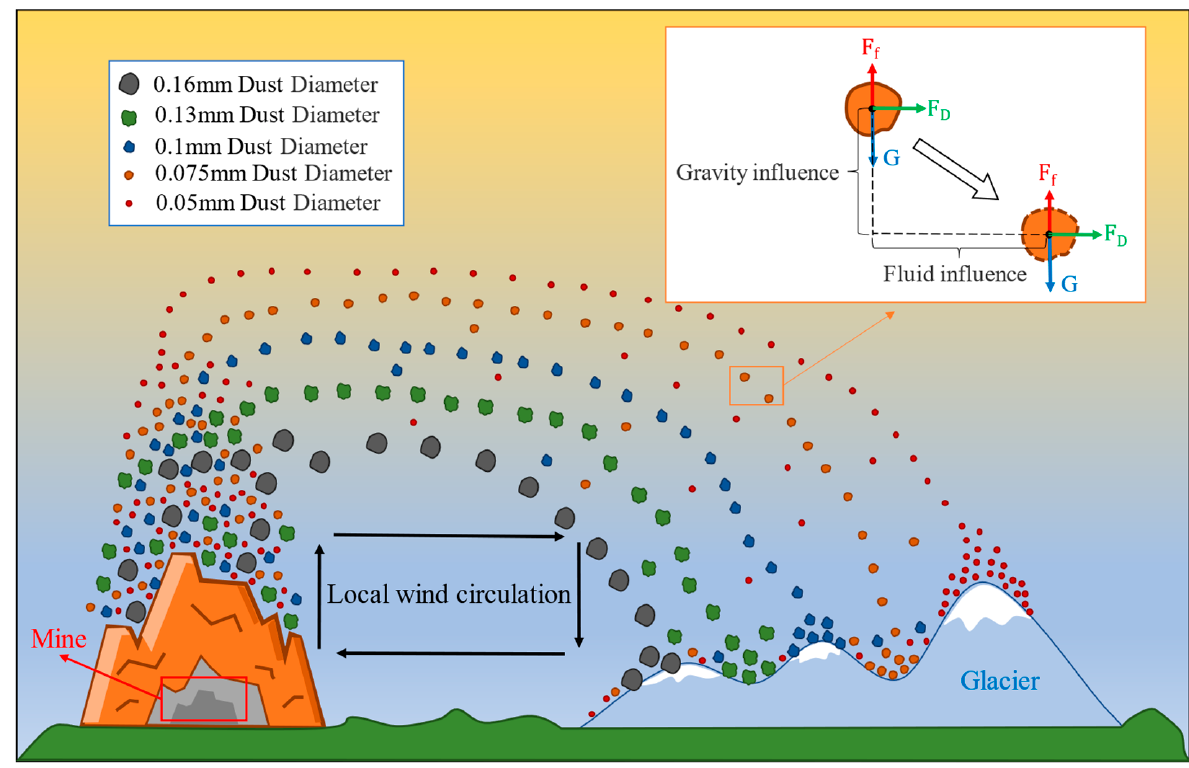
Figure 11. Different sizes of dust particles settling on the glacier surface under the action of atmos- pheric circulation.